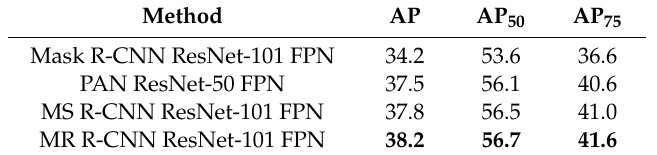
Table 3. Instance segmentation mask prediction results on 300 images from Cityscapes.